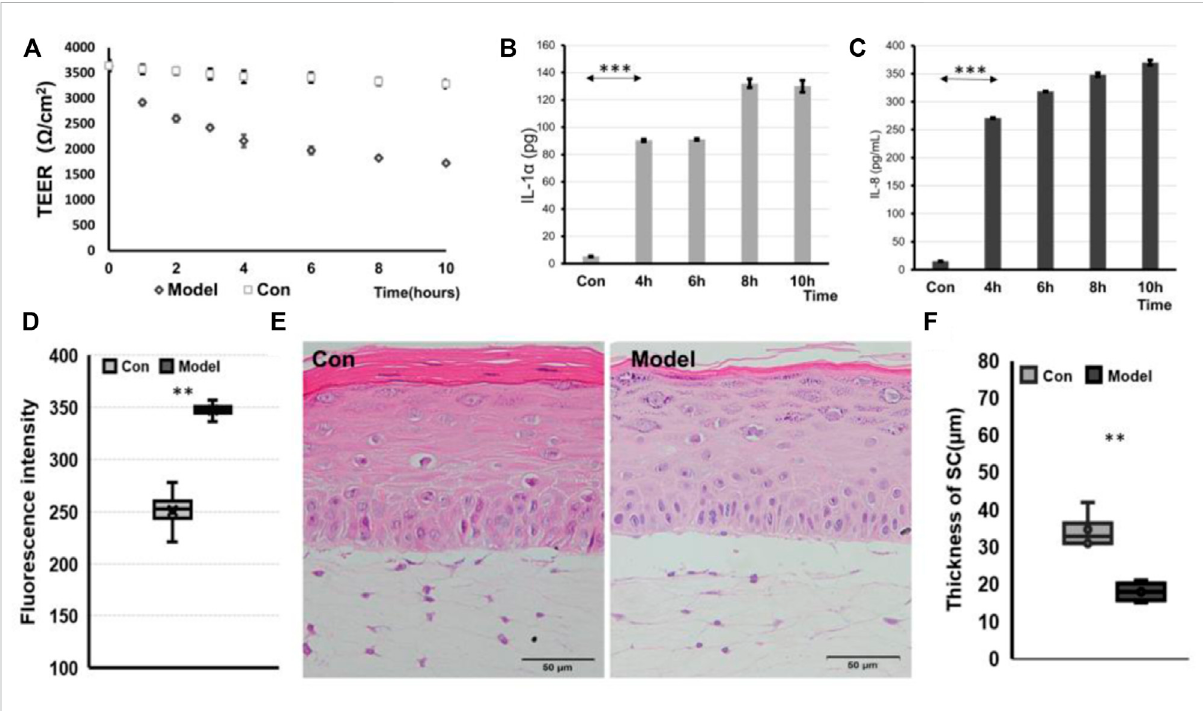
FIGURE 5 IC-SoC in fl ammatory response. (A) TEER values of control (Con) and model (exposure to SLS + P.acnes ) at different times in response to stimulation. (B) and (C) graphs showing the release of IL-1 α and IL-8 cytokines in response to stimulation. (D) Fluorescent molecule permeability of control (Con) and model (exposure to SLS + P.acnes ) for 10 h. (E) H&E cross section of control (Con and model. (F) Statistical analysis of SC thicknesses in the skin of control (Con) and model ( n = 5 per condition, p ** < 0.01; p *** <